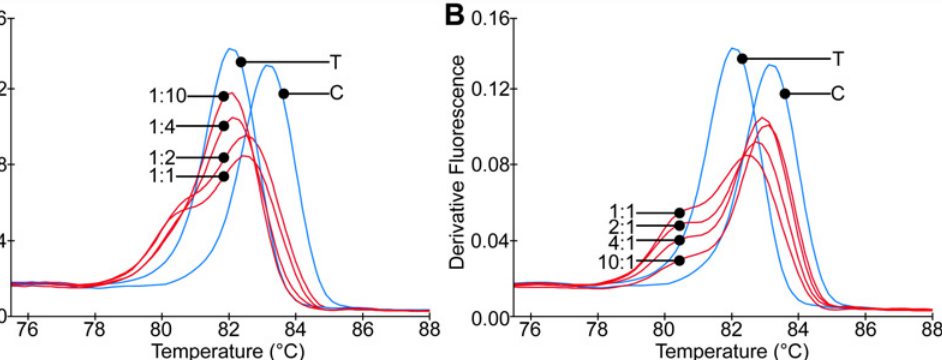
Fig 1. qPCR-HRM assays quantify alleles within DNA mixtures. The derivative melt graphs show the T m profiles of a representative assay (12) tested with mixtures of clinical samples known to contain only one allele at this assay position. The ratios of genomic DNA from samples containing reference (C) allele to alternate (T) allele in the mixtures were: (A) 1:10, 1:4, 1:2, 1:1 and (B) 10:1, 4:1, 2:1 1:1. The other 41 assays not shown were tested similarly and all performed comparably to detect mixed allelic samples.